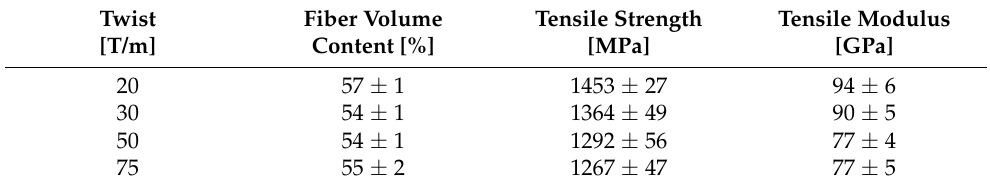
Table 2. Mechanical properties of UD composites from rCF-PA 6-hybrid yarns with varying twists